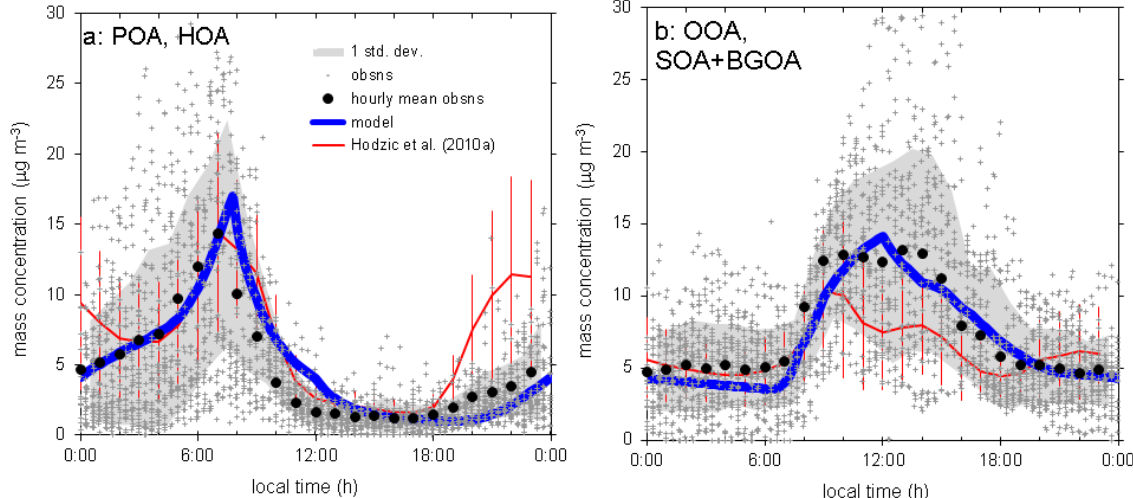
Fig. 6. The diurnal cycle of organic aerosol mass in Mexico City during March 2006. (a) Observed HOA and modeled POA; (b) observed OOA and modeled SOA plus 2µgm − 3 background aerosol (BGOA). Observations are from 8–30 March 2006 (Aiken et al., 2009).